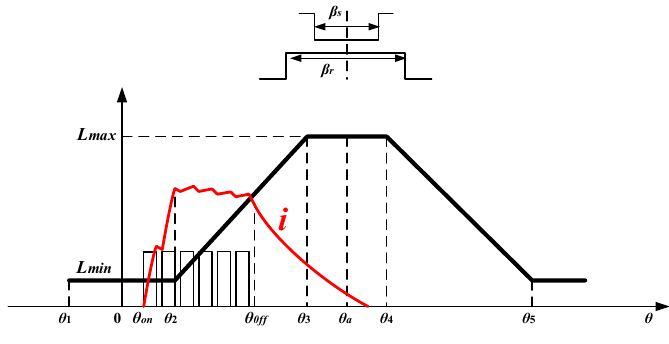
Figure 11. Phase-A current under voltage chopping.